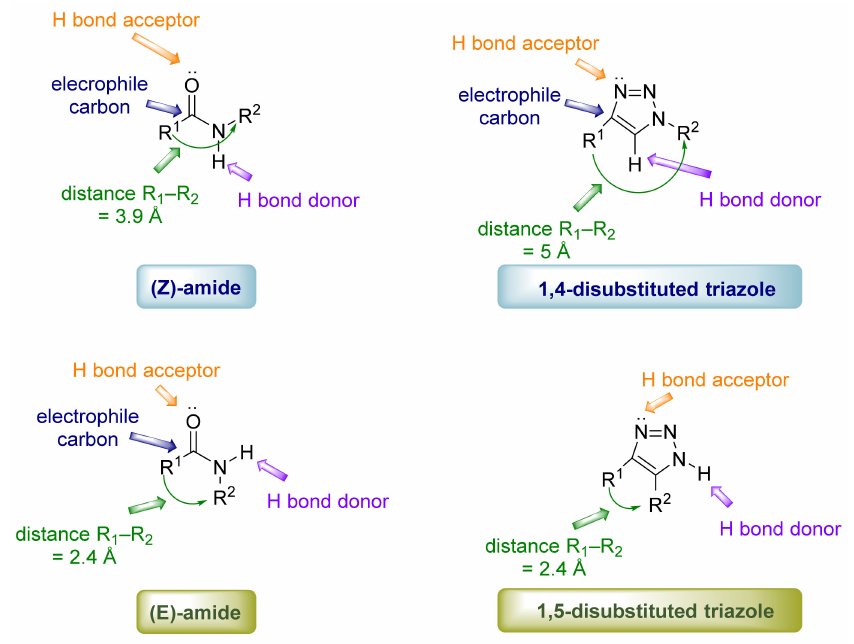
Figure 1. Topological and electronic mimicry of amide units by 1,2,3-triazoles. Additionally, certain 1,5-disubstituted 1,2,3-triazoles can mimic the cis-peptide bond, but with a different